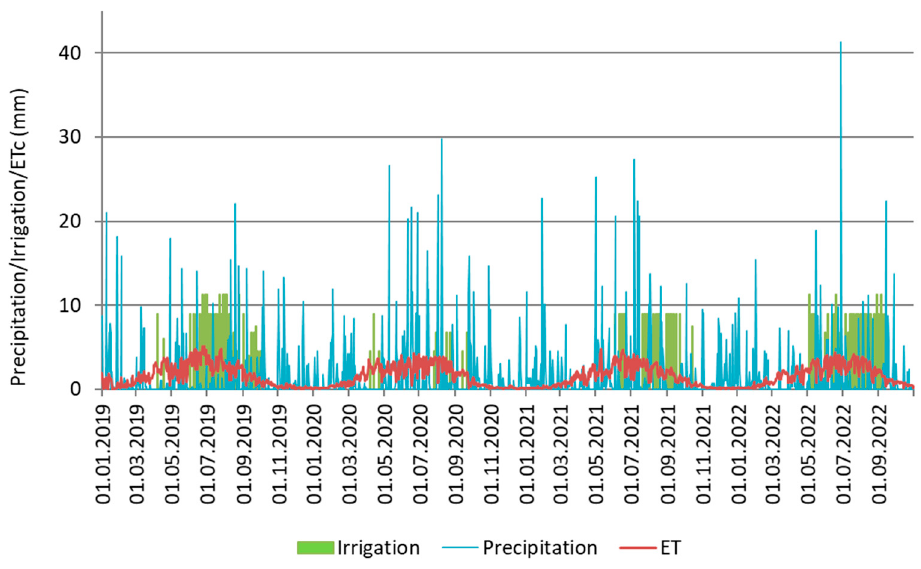
Figure 1. The map of the experimental site in the Czech Republic. The site belongs to a region with temperate climate conditions, with a mean annual temperature (1964–2021) of 8.8 °C and rainfall of 664 mm; the respective means of the experimental years (2019–2021) were 9.8 °C and 614 mm. The reference evapotranspira- tion (Penman-Monteith, ETo) was approximately 560 mm, with a maximum month sum from June to August (81–95 mm). The negative water balance and water deficit occurred mostly during summer. Water availability was affected by a fluctuation of precipitation (Figure 2) and water reserves in the root zone. The water table was approximately 5 m deep, and it did not influence the soil water in the root zone during the vegetation season.